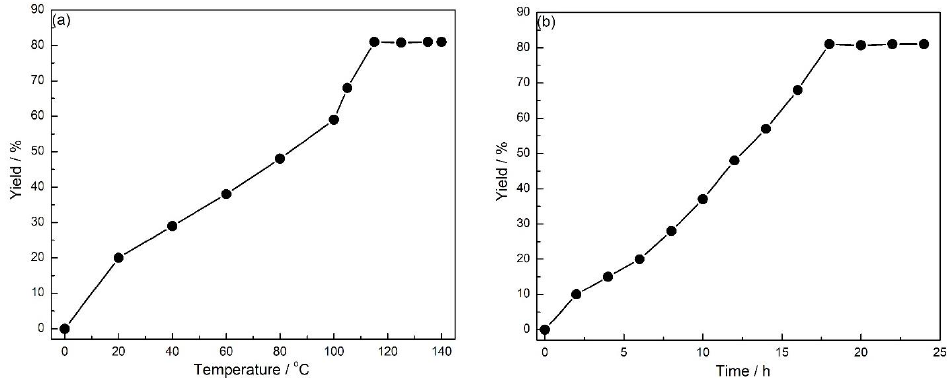
a Reaction conditions: o -phenylenediamine, 1.0 mmol; pressure, 30 bar; time, 18 h. b Isolated yield calculated from the 1 HNMR.